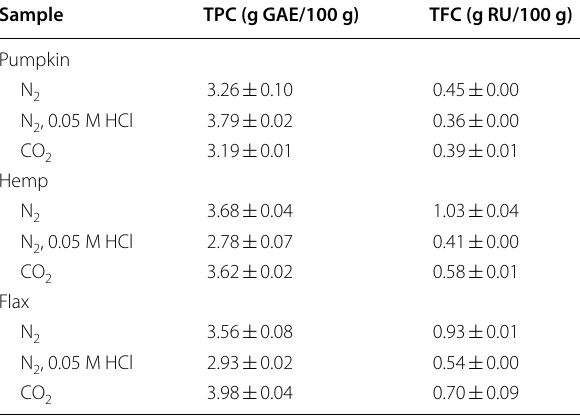
Table 1 Total phenol and flavonoid contents in